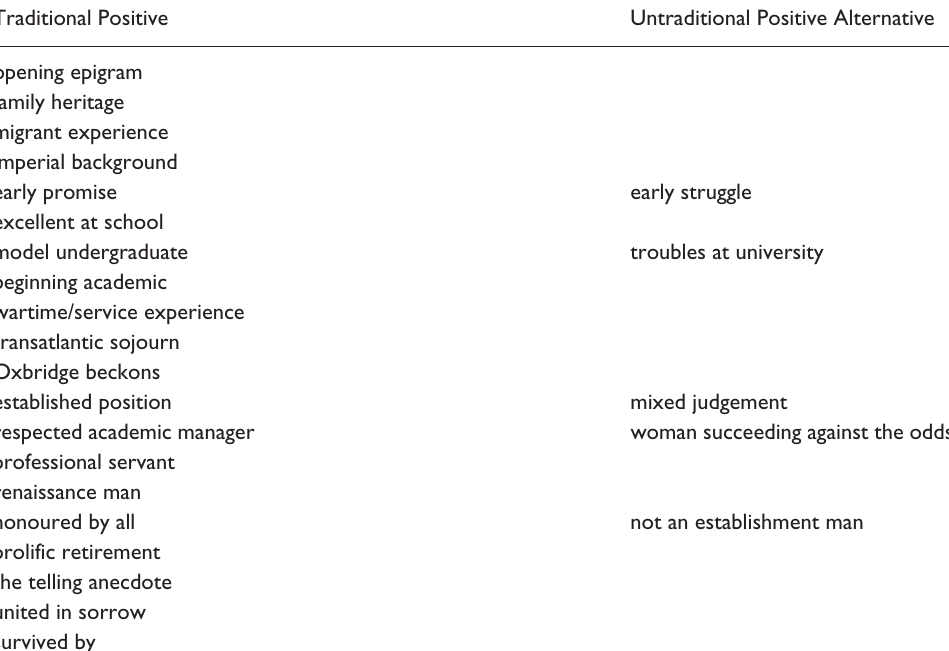
Table 1. Common elements in academic